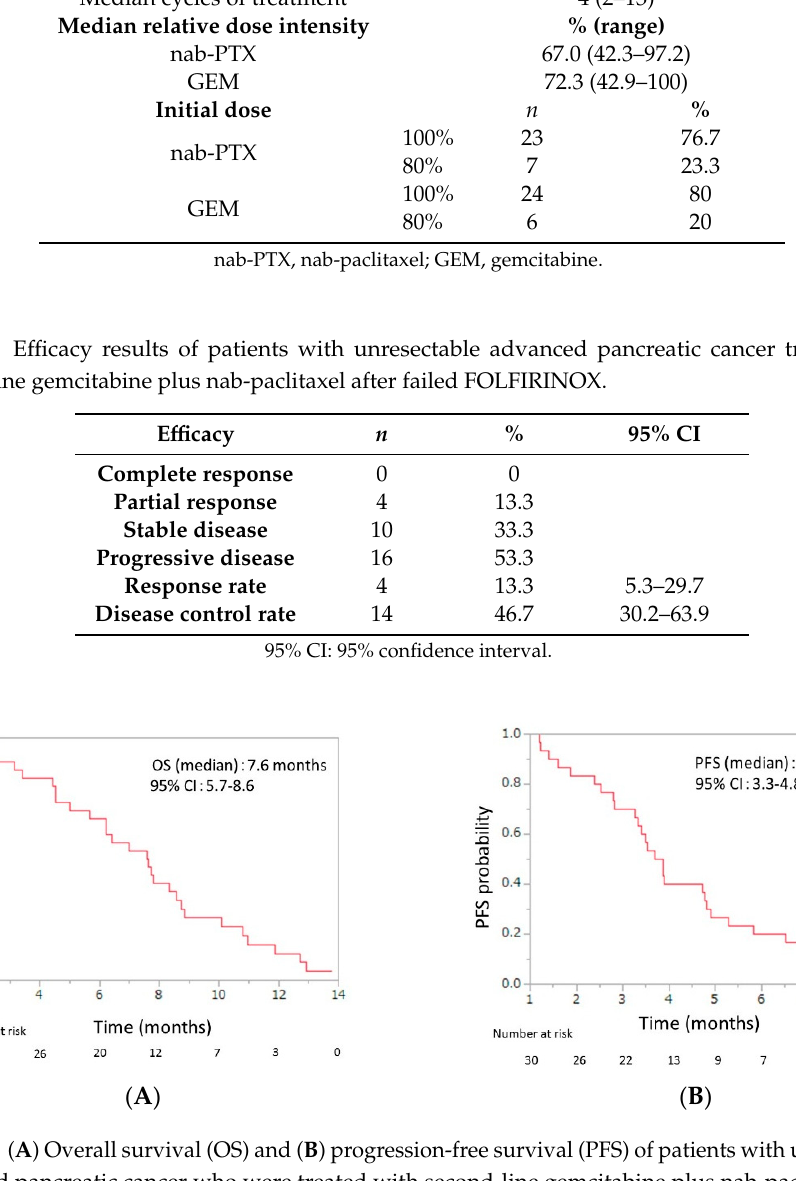
Table 3. Treatment duration and drug delivery of patients with unresectable APC treated with second-line gemcitabine plus nab-paclitaxel after failed FOLFIRINOX.